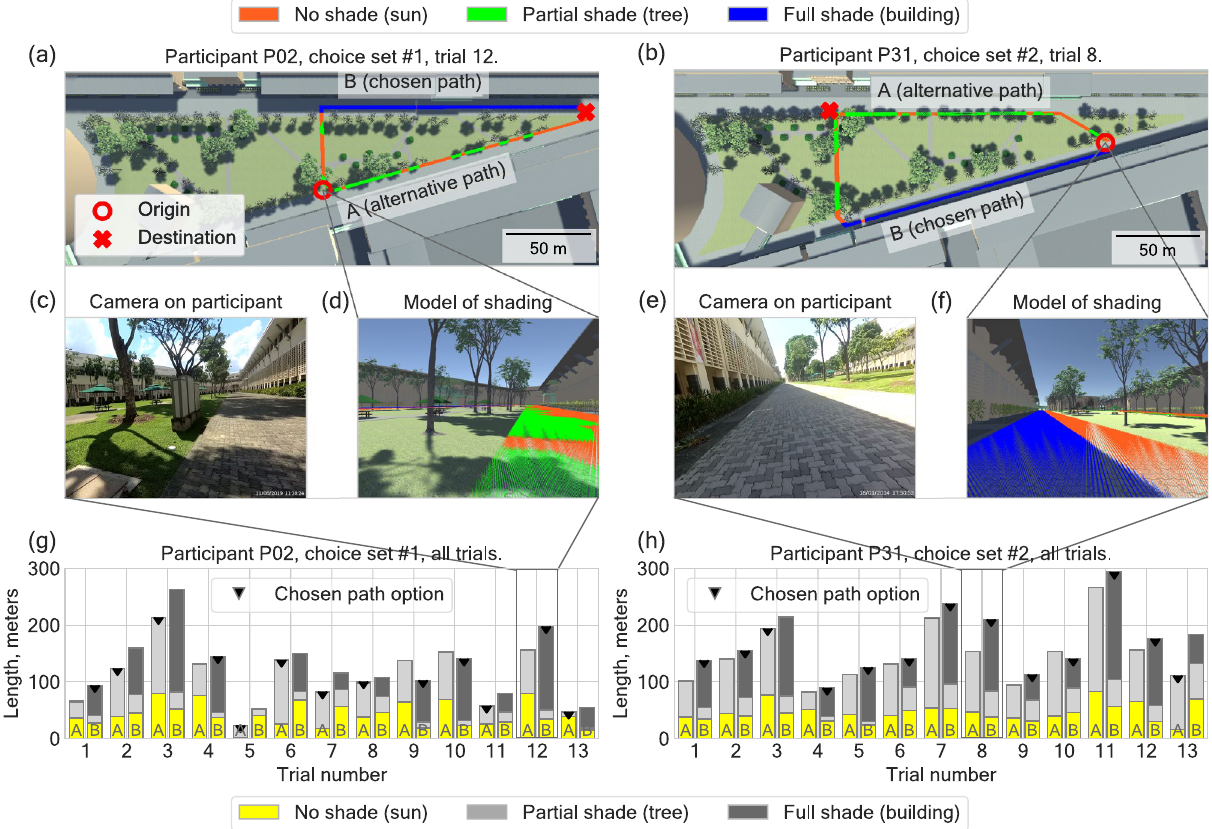
Figure 1. Description of the path choice behaviour experiment and resulting dataset. (a,b) At each trial participants of experiment were tasked to reach the destination indicated by cross by walking on one of two paths specified on schematic map of the experimental area given to them. Depending on the time of the year the sun was positioned in either the northern (a) or southern (b) part of the sky. To maximise the number of choices with a trade-off between sun exposure and distance, two different choice sets for two times of the year were designed. (c,e) Participants wore action cameras to record their actions and decisions, which were later used to reconstruct the decisions and to calibrate the 3D model. (d,f) A calibrated computational model of the experimental area was used to calculate the sun-shade composition of the path options. (g,h) Each participant completed a series of 13 trials, each being a choice between two path options characterised by sun-lit (yellow), tree-shaded (light grey) and building-shaded (dark grey) length. The figure is generated with use of package matplotlib v3.2.2 (https:// matpl otlib. org/) for Python v3.7.7 and Unity 3D (https:// unity. com/)